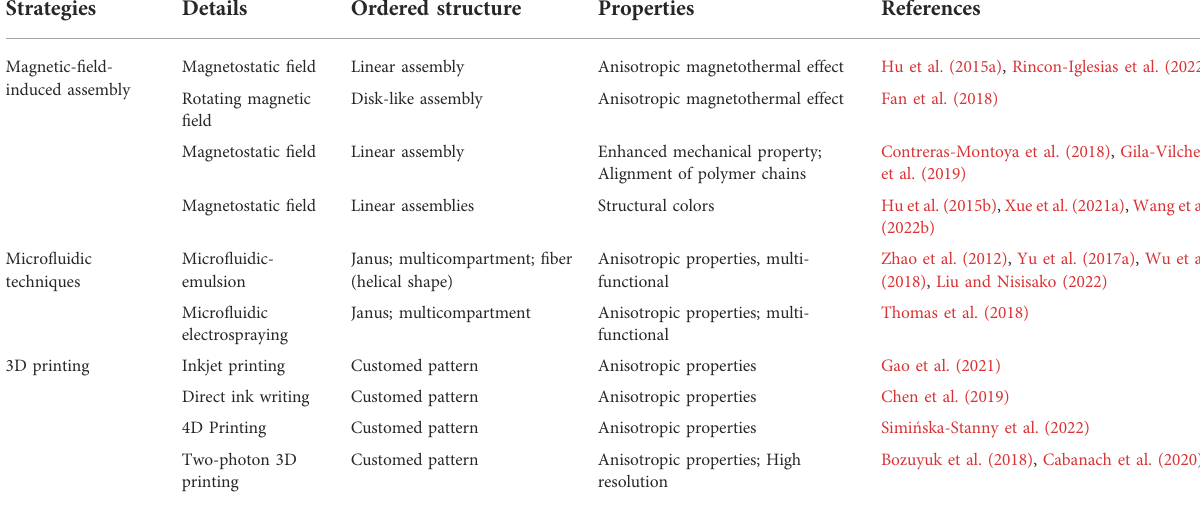
TABLE 1 The preparation strategies of magnetic hydrogels with ordered